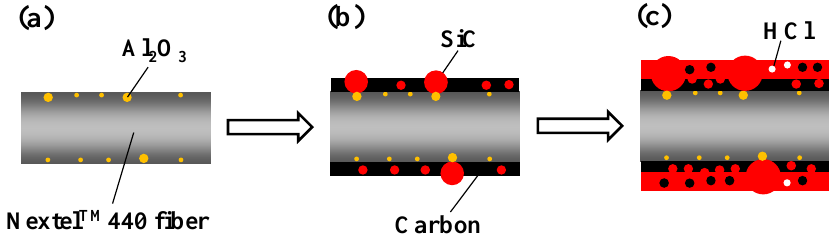
Figure 9. Schematic of the deposition mechanism for SiC coatings on Nextel TM 440 fibers: ( a ) the original fiber, ( b ) initial stage of deposition and ( c ) later stage of deposition.